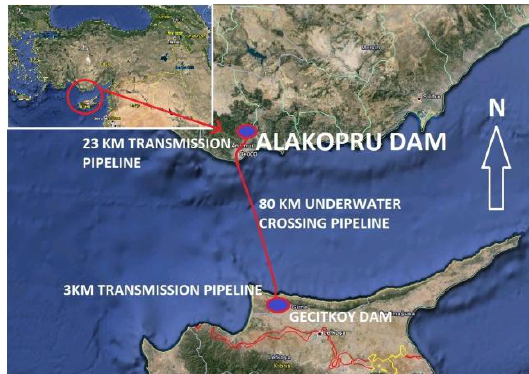
Figure 1: The map of the study area showing the water pipeline project route.